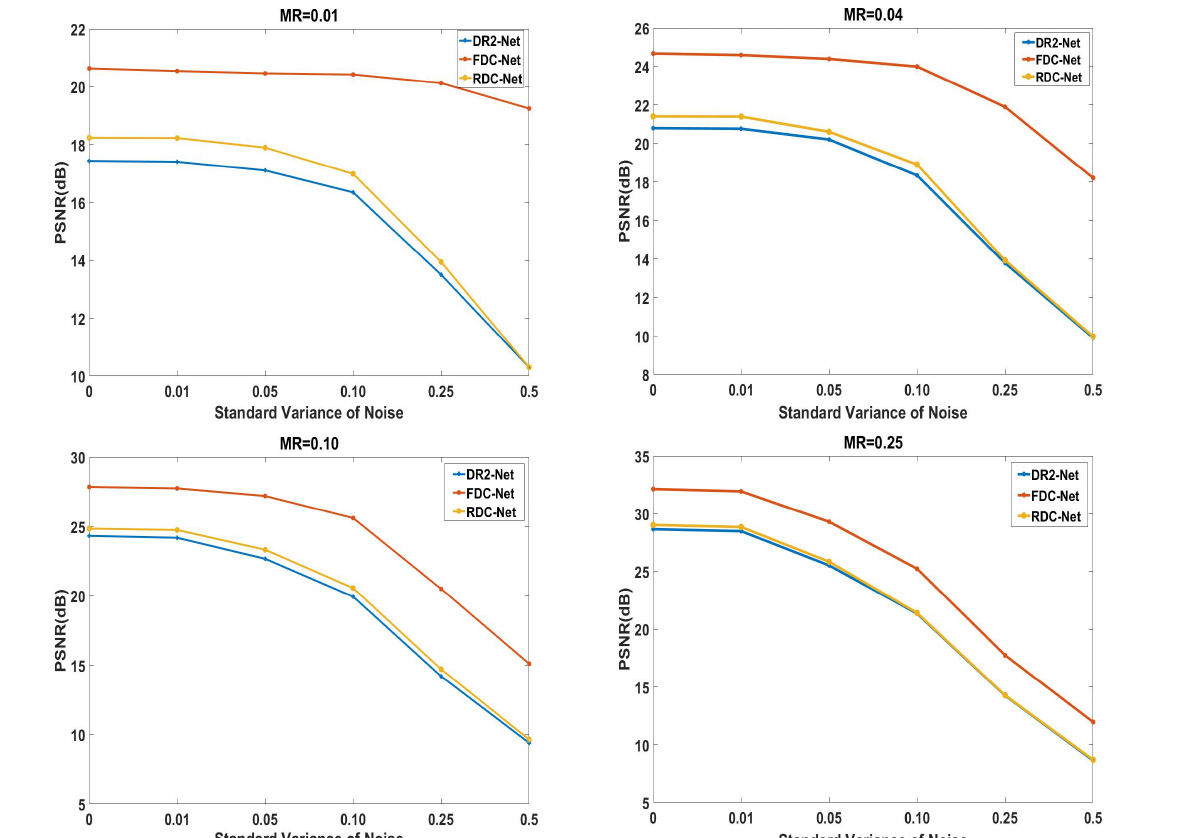
Figure 6. Robustness comparison to different Gaussian noise among the different